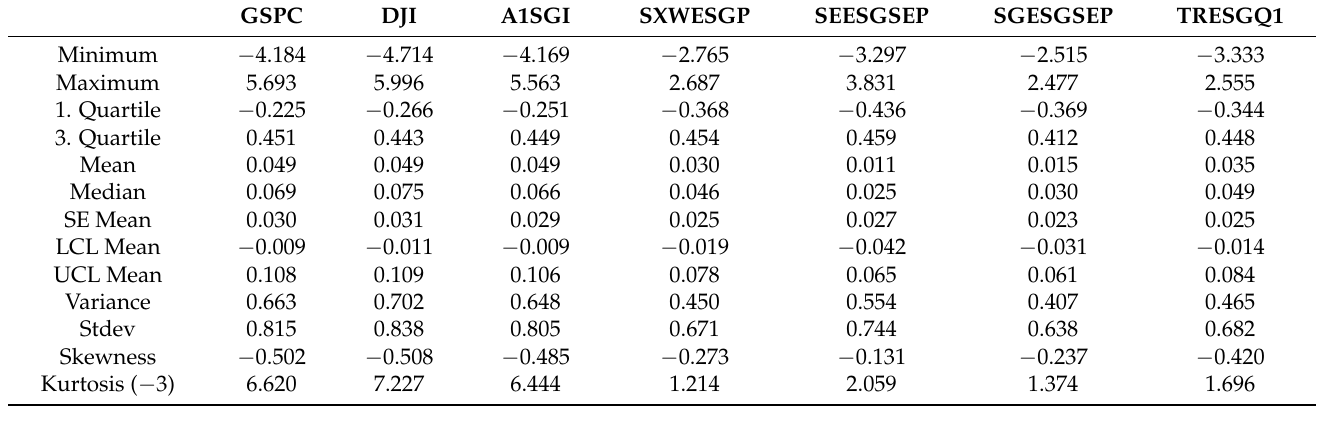
Table 10. Descriptive statistics, 4 January 2017–31 December 2019.